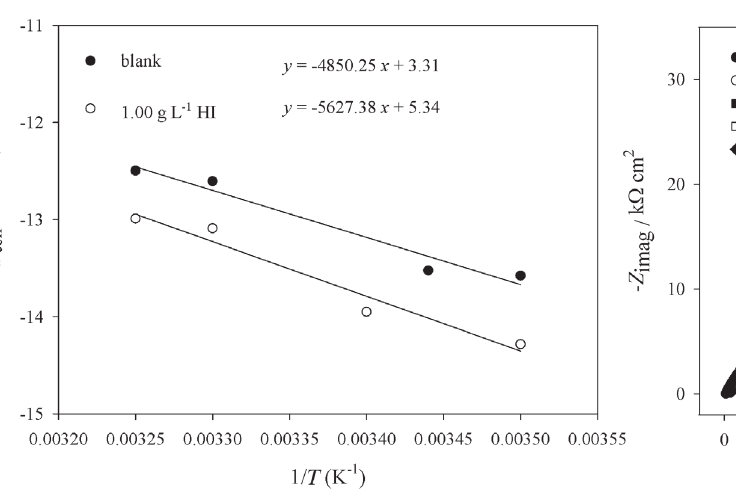
Fig. 5 – Arrhenius plots of Cu in simulated acid rain with and without 1.00 g L –1 of HI extract